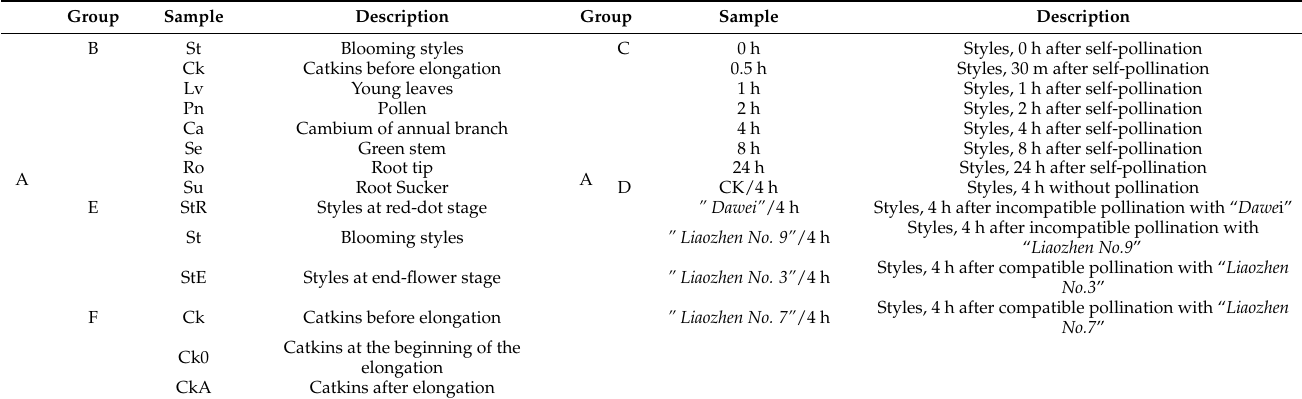
Table 9. Description of